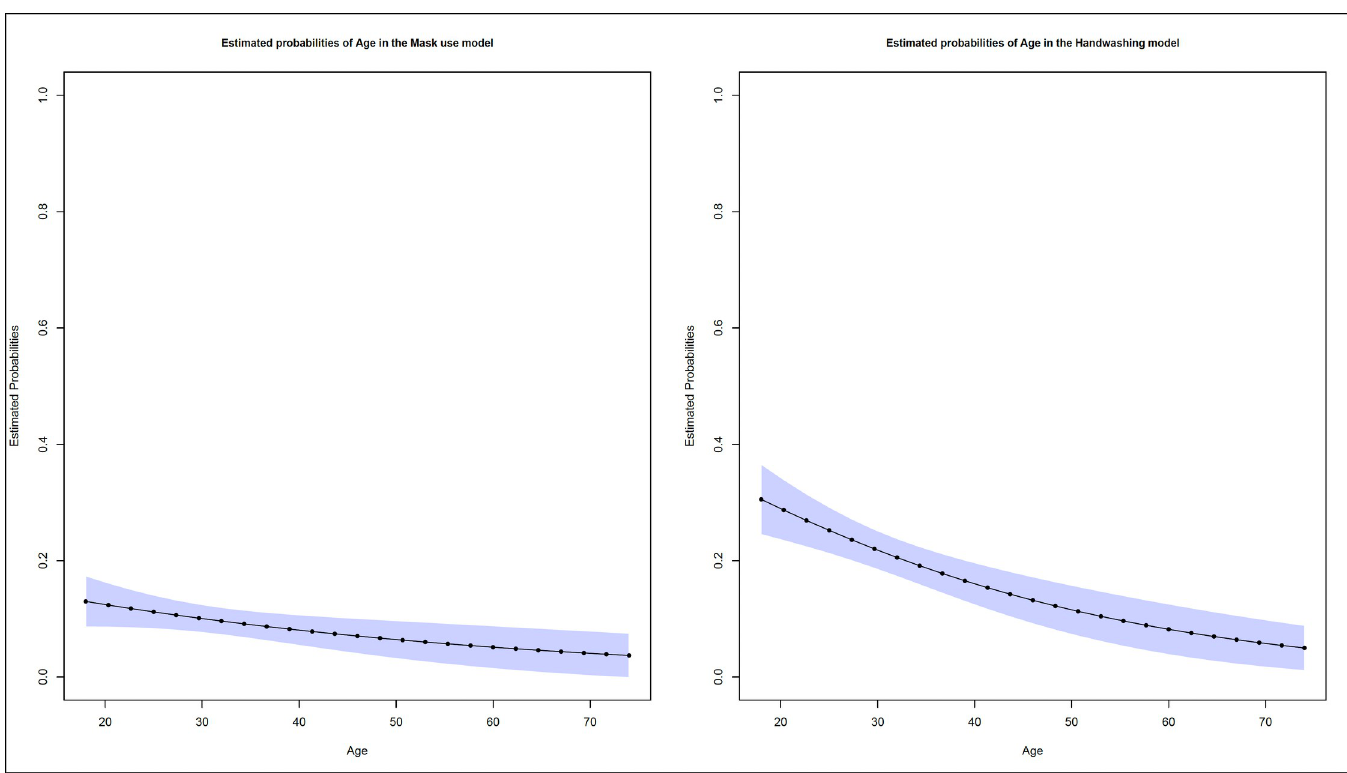
Fig 3. Probabilities estimated by logistic regression for age and sex in the distancing model and with confidence intervals of 95%. The probabilities shown in the figure were estimated by a logistic regression fitted with only the significant variables at level 5%.